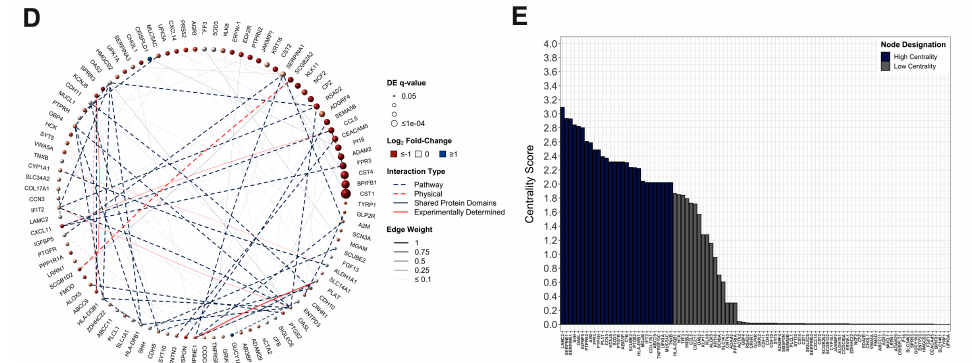
Figure 2. Ontological and Functional Analysis of the Quiescent Breast Cancer Cell Transcriptome. ( A ) Agglomerative hierarchically clustered heatmap of mean-centered, TMM normalised log 2 -transformed CPM gene expression values as quantified by mRNA-Seq. Clustering is unsupervised and based on Euclidean distances calculated from an average-linkage matrix. All genes detected as differentially expressed with a log 2 fold-change significantly above 1.5 (up-regulated) or below − 1.5 (down-regulated) at an FDR-adjusted p -value ( q -value) ≤ 5% across all breast cancer cell lines are shown (127 total). Grey and red bars represent Vybrant ® DiD − negative (DiD − ) and Vybrant ® DiD − positive (DiD+) grouping, respectively. ( B ) Gene set enrichment analysis of the differentially expressed genes using MSigDB hallmark collection gene ontologies denoted by enrichment score normalised to mean enrichment of randomised equivalent samples (hypergeometric test with post-hoc Benjamini-Hochberg FDR adjustment). ( C ) Analysis of leading edge genes identified as driving significant enrichment of MSigDB hallmark collection gene sets. Columns indicate quiescence-associated signature genes contributing to the enrichment signal of the gene set(s) indicated by row labels. Colour is scaled to the number of leading edge gene sets in which each gene appears. For clarity, only signature genes that appear in ≥ 1 ontologies are shown. ( D ) Composite functional association network constructed for genes detected as differentially regulated with a log 2 fold-change significantly above 1.5 (up-regulated) or below − 1.5 (down-regulated) at an FDR-adjusted p -value ( q -value) ≤ 5% across all four breast cancer cell lines. For clarity, only empirically determined (non-inferred) network members are shown. Vertex (circle) size is proportional to FDR-adjusted p -value of differential regulation ( q -value); node colour is proportional to the log 2 fold-change between proliferative and quiescent breast cancer cells. Connecting edge (line) colour and type represents interaction relationship. Edge thickness is proportional to linear regression–derived network weighting. ( E ) Topological analysis of the quiescence-associated signature gene network. Centrality score represents the log 10 transformed combined centrality metrics (total degree, betweenness, eigenvalue, and closeness) calculated during topological analysis. Genes with combined centrality scores in the upper − quartile (75th percentile) are designated as “high centrality” while those that failed to meet this cut-off as “low